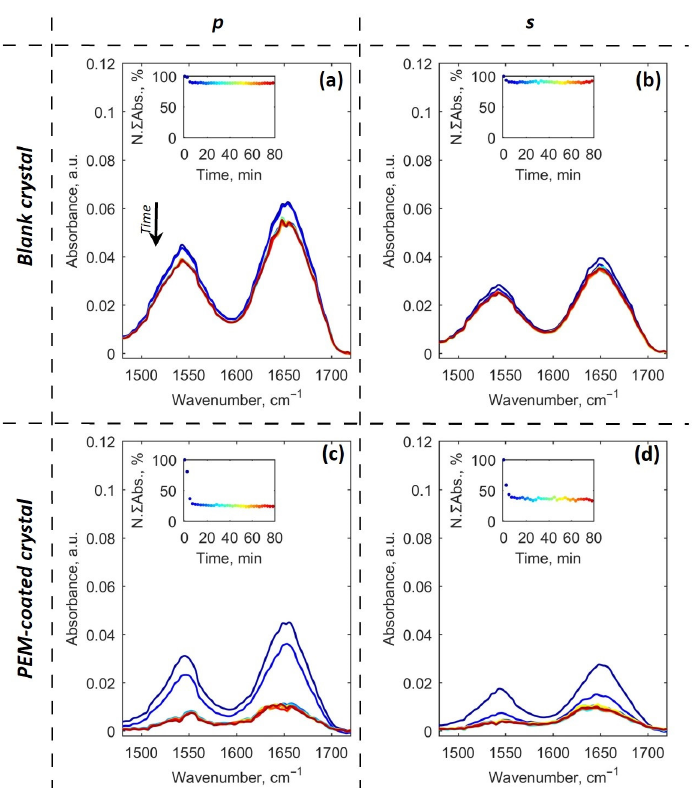
Figure 2. ATR-FTIR spectra recorded during desorption studies of the protein when the protein solution was replaced by buffer. Data are shown for the blank ( a , b ) and PEM-coated ( c , d ) crystal for p and s polarizations (respectively). The arrow in ( a ) indicates the direction of the time span. Inset graphs show the time course of the total absorbance normalized by the total absorbance of the last spectrum recorded during adsorption studies. The colors of the data (from cold to warm) reflect the direction of the time span. The colors of the spectra are in accordance with the colors of the data in the inset graphs.